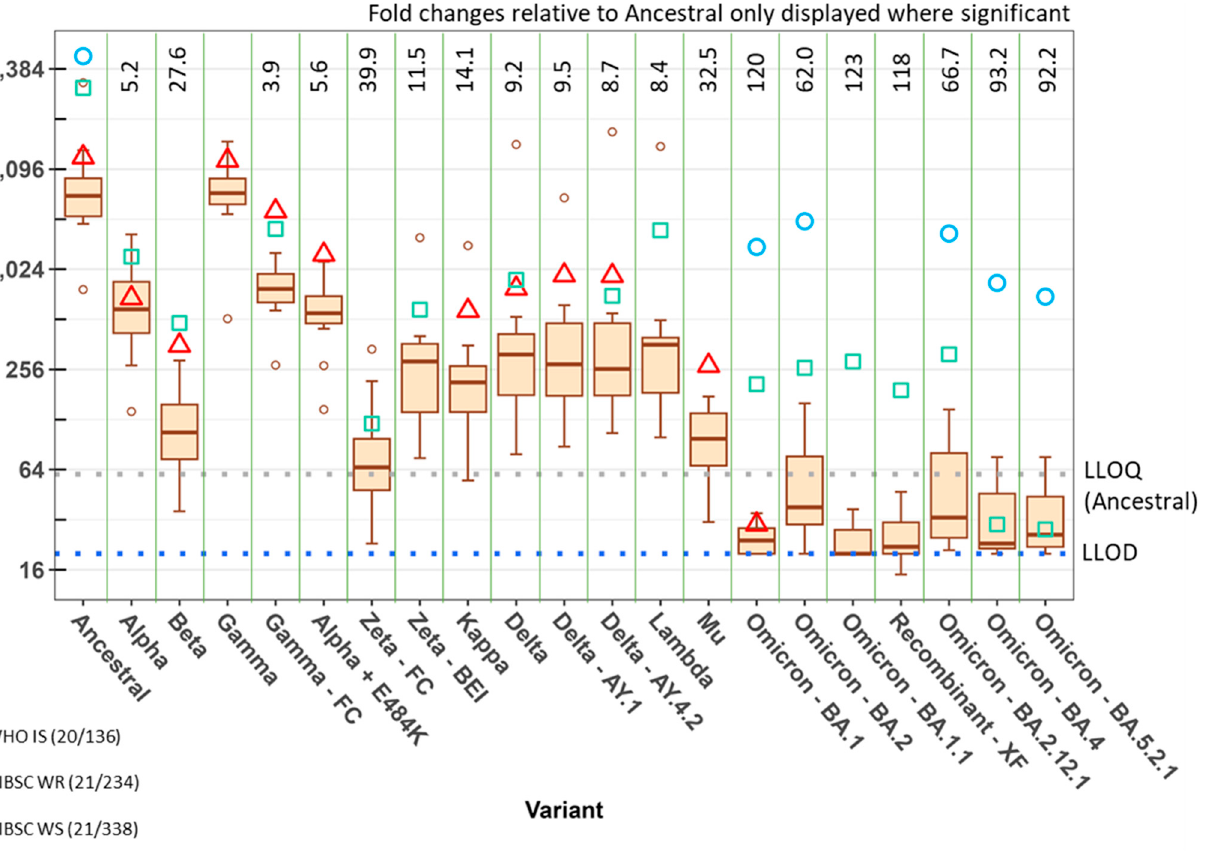
Figure 1. Neutralising antibody titres of a panel of pre-Alpha convalescent plasma determined with FRNT at two independent laboratories against authentic SARS-CoV-2 variants. A panel of 11 pre-Alpha convalescent plasma were assessed at UKHSA and MHRA with FRNT over a dilution range of 1/20 to 1/40,960 with 20 authentic SARS-CoV-2 variants. Data are presented as median and interquartile ranges of titre ND 50 and are ordered by date of variant emergence. Fold changes relative to ancestral virus were calculated with regression analysis using a linear mixed-effect model and are presented where the difference is significant (two-way ANOVA with Tukey’s post hoc test). The lower limit of detection (LLOD) of 1/20 is indicated by the blue dotted line. The lower limit of quantification (LLOQ) of 1/58, as determined for the ancestral assay, is indicated by the grey dotted line. Neutralisation titres of the WHO IS 20/136, NIBSC WR 21/234, and 21/338 are presented as a red triangle, green box, or blue circle, respectively.